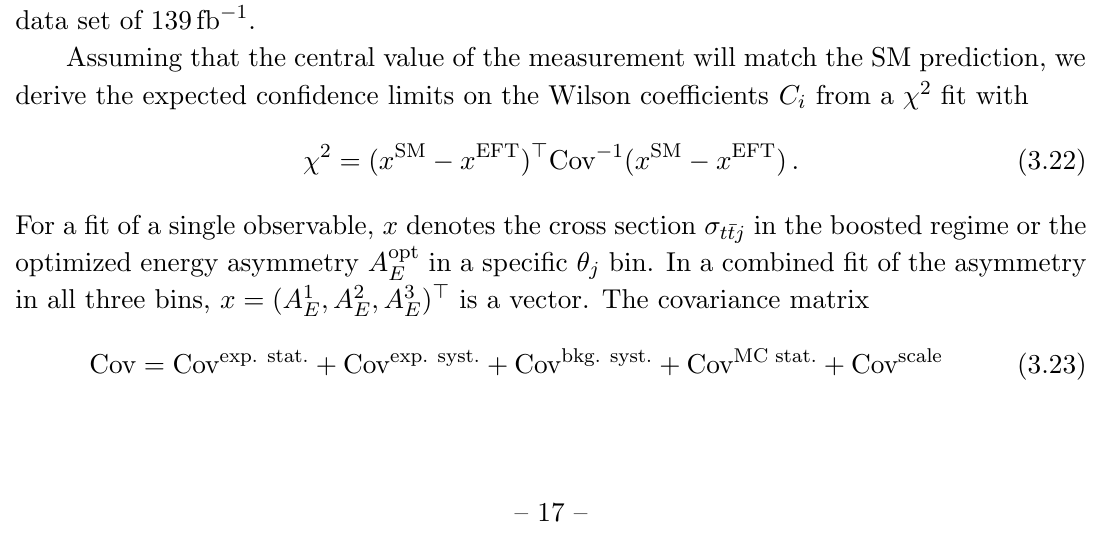
di(cid:11)erent for each of the three bins A i but negative in bin